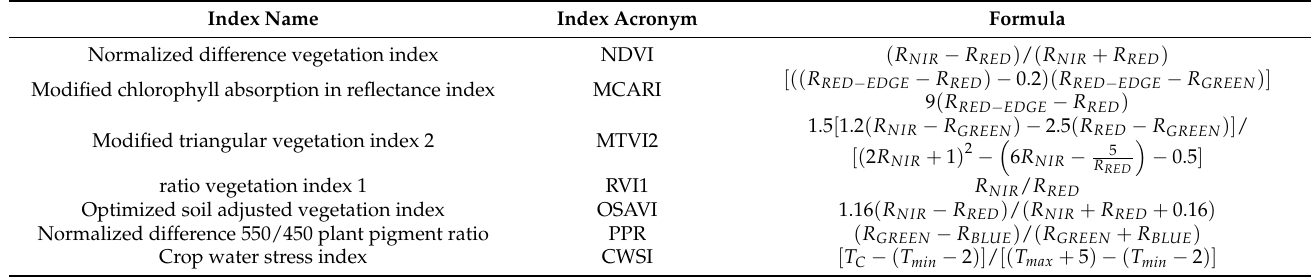
Table 2. List of 7 vegetation indices we have examined in this